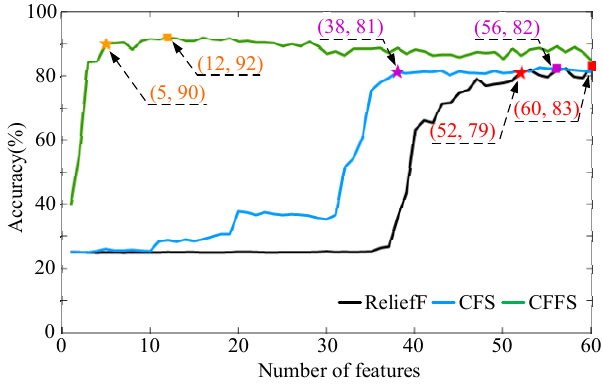
Figure 15. Accuracy curve of ReliefF, CFS, and CFFS.